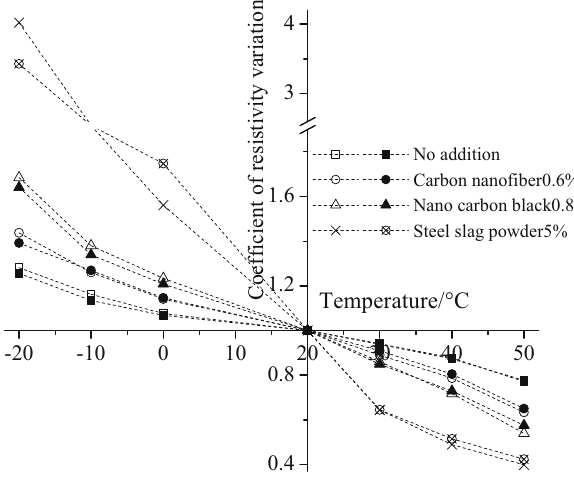
Figure 6: Relationship between temperature and coe ffi cient of resistivity